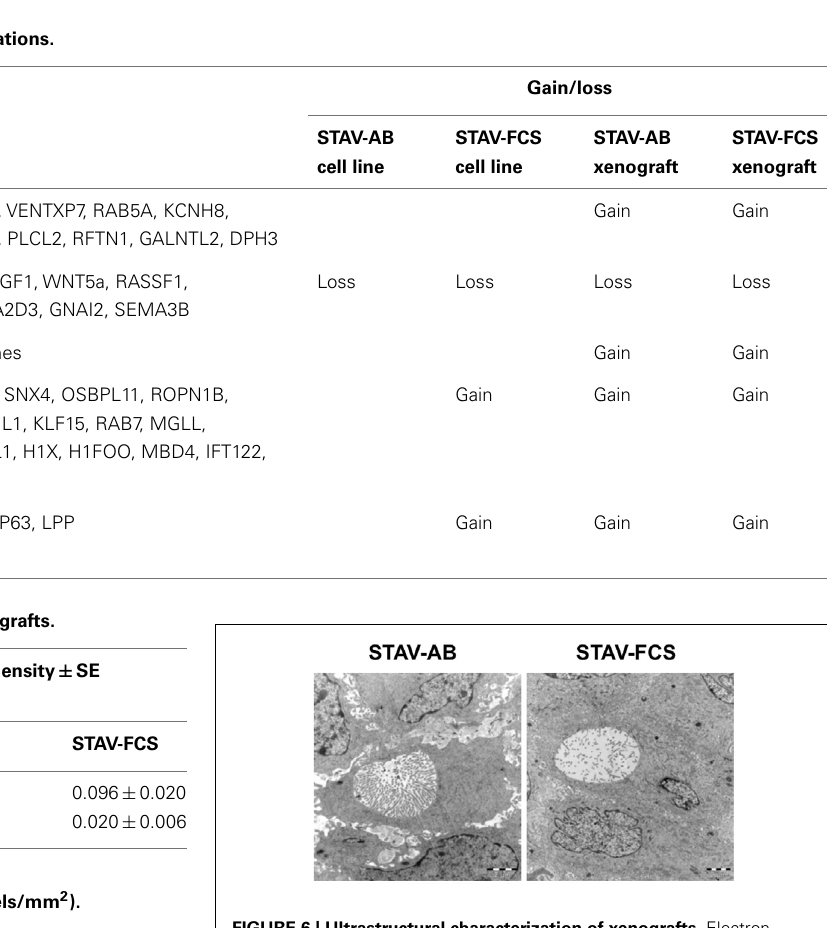
FIGURE 6 | Ultrastructural characterization of xenografts . Electron microscopy revealed the presence of microvilli-laden neolumina in xenografts from both phenotypes. A greater density of microvilli was consistently found in the STAV-AB-derived xenografts.The density of microvilli was strikingly lower in the STAV-FCS-derived xenografts, suggesting that the cells displayed a less differentiated state. Scale bars are 2 µ